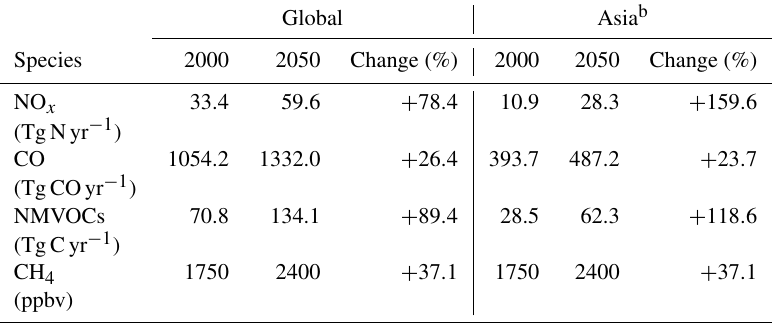
Table 1. The anthropogenic emissions a of O 3 precursors for the present day (the year 2000) and the future (the year 2050; under the SRES A1B